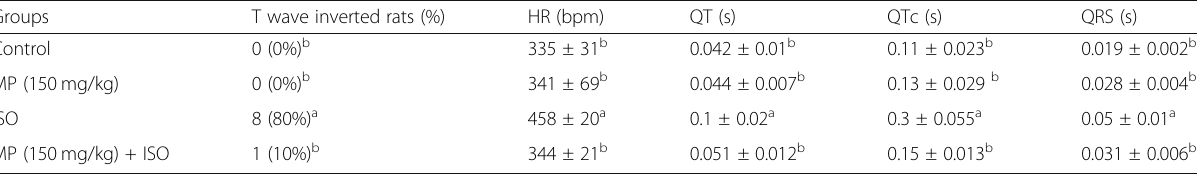
Table 1 Effect of MP (150 mg/kg) on ECG pattern in ISO-intoxicated rats Groups T wave inverted rats